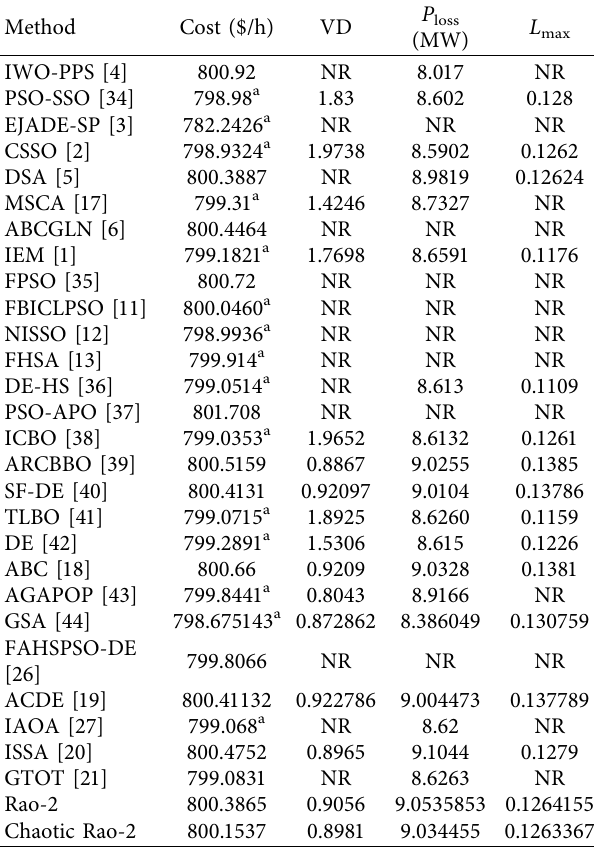
Table 3: Comparison study for case